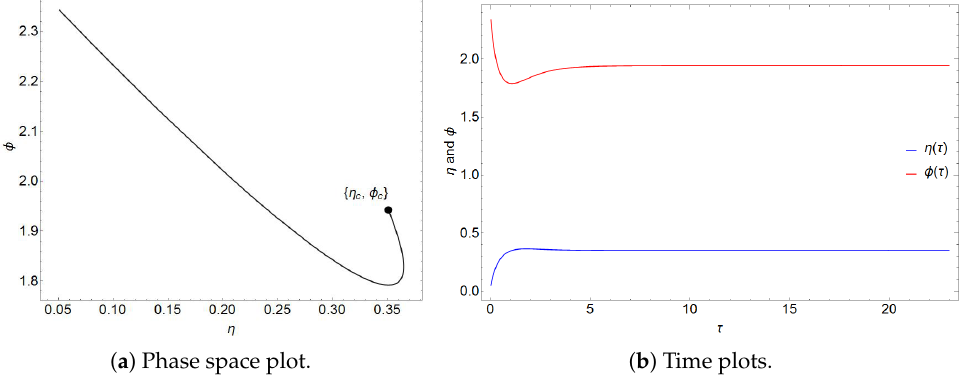
( a ) Phase space plot. ( b ) Time plots. Figure 1. Plots with initial conditions η ( 0 ) = 0.05 and φ ( 0 ) = 2.34.